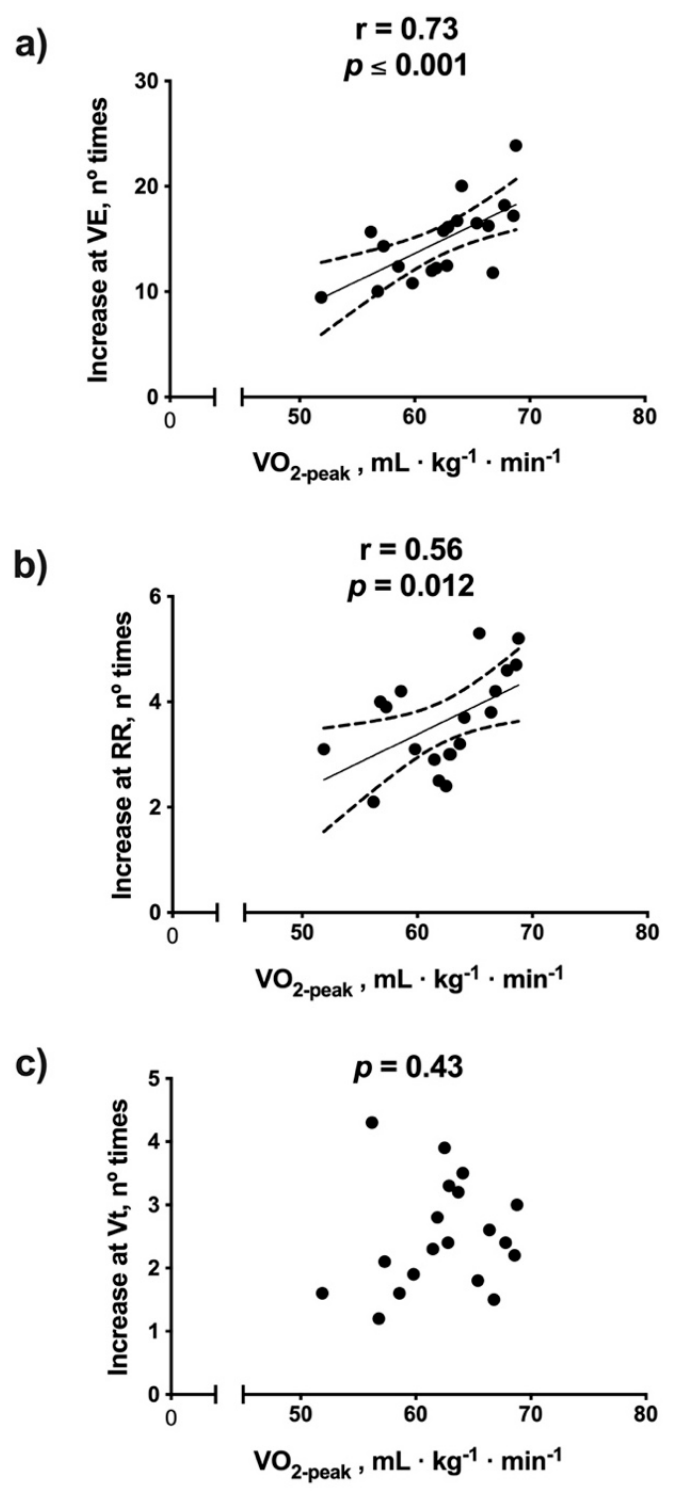
. Figure 2. Association between VO 2 (oxygen consumption) and the number of times that: ( a ) Figure 2. Association between V(cid:4662) O 2 (oxygen consumption) and the number of times that: ( a ) V(cid:4662) E (lung ventilation), ( b ) RR (respiratory rate) and ( c ) Vt (tidal (lung ventilation), ( b ) RR (respiratory rate) and ( c ) Vt (tidal volume).